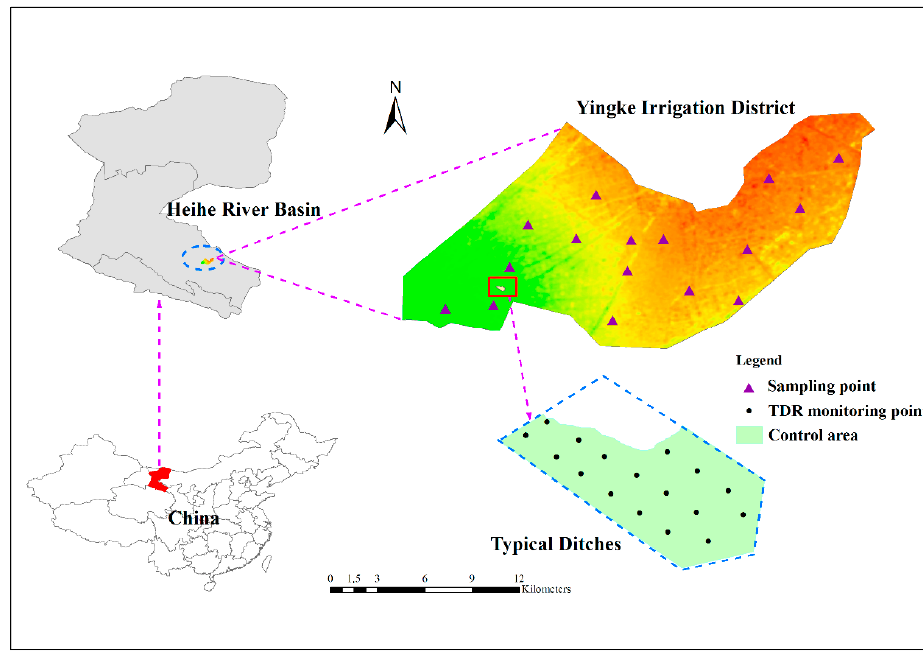
Figure 1. Location of the Yinke irrigation district.